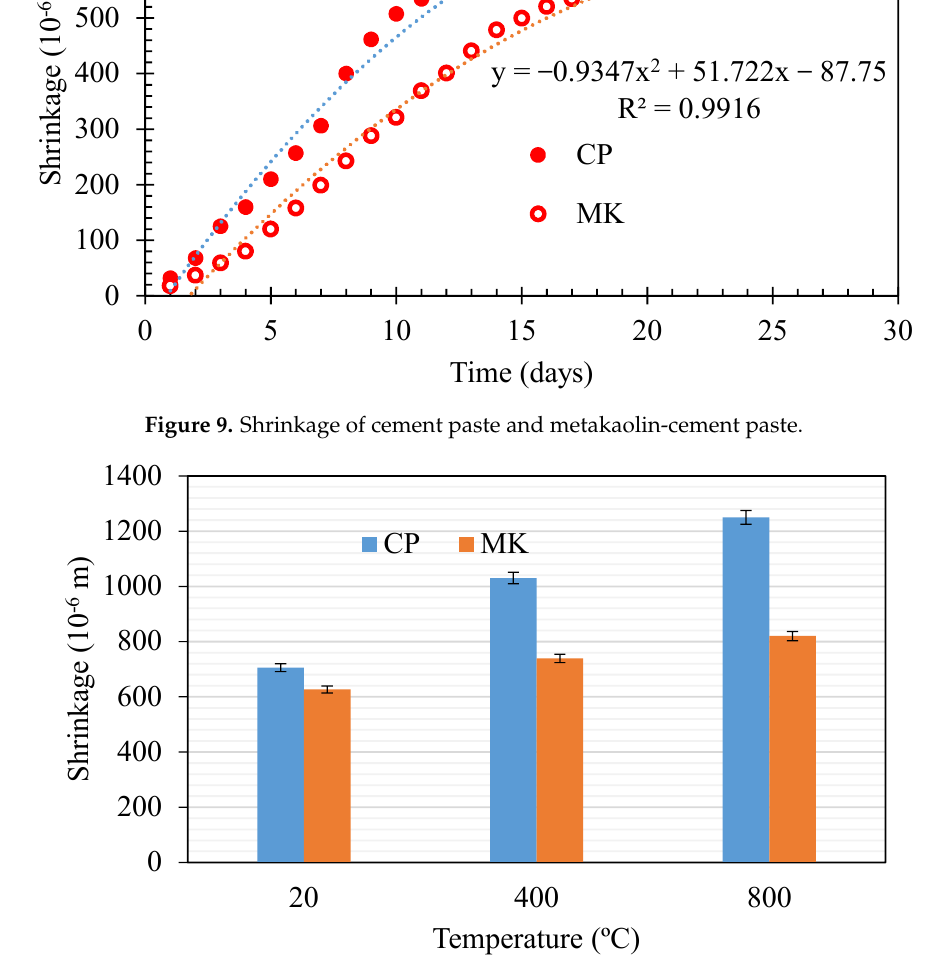
Figure 10. Effect of elevated temperatures on shrinkage of cement paste and metakaolin-cement paste.